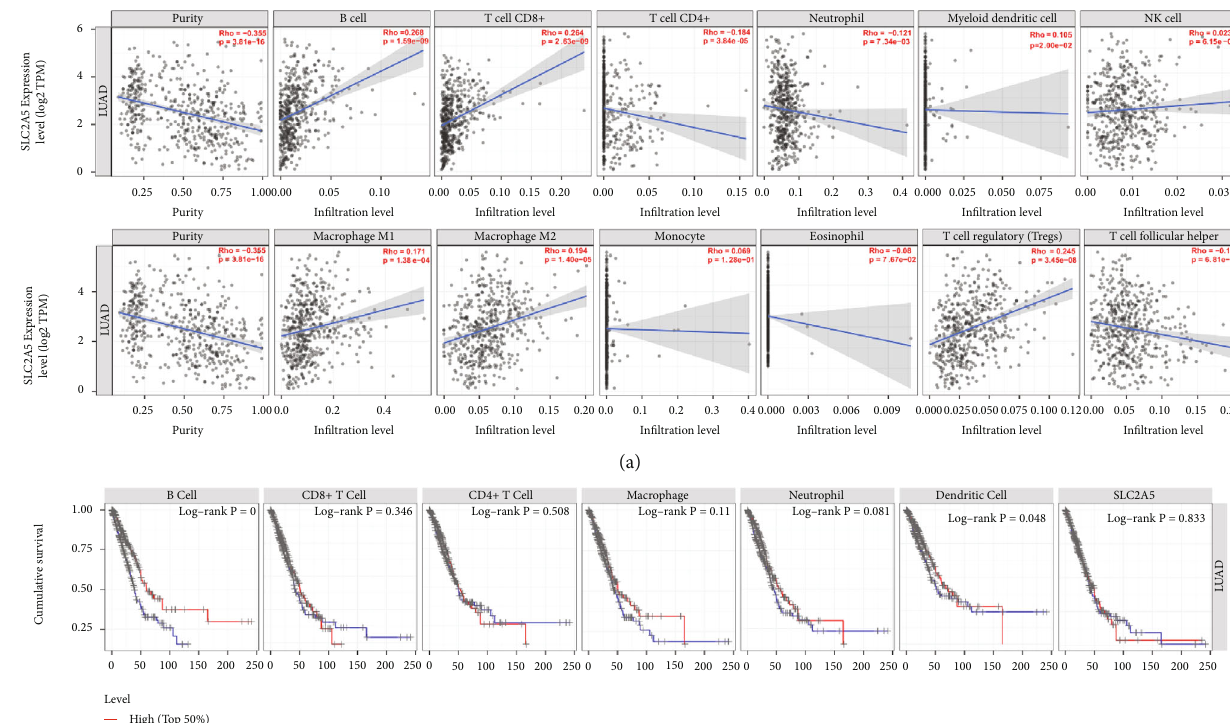
Figure 4: Correlation analysis between SLC2A5 expression and the in fi ltrating immune cells in LUAD. (a) Correlation of SLC2A5 expression with 12 types of immune in fi ltration cells obtained from TIMER (purity-corrected Spearman test). (b) Overall survival curve of the six types of cells produced by Kaplan-Meier estimator from TIMER. Survival di ff erences are compared between patients with high and low (grouped according to median) in fi ltration of each kind of immune